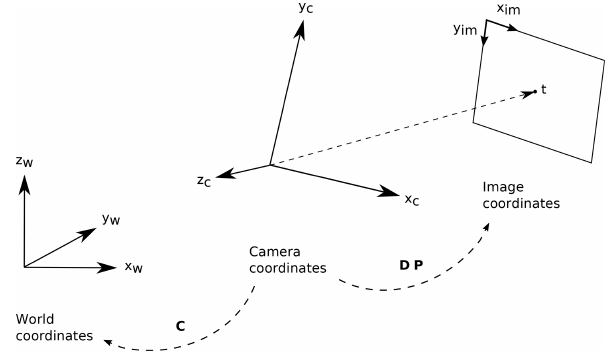
Figure 6. World, camera, and image coordinate systems and their transformations using camera matrix C , perspective projection ma- trix P , and viewport matrix D